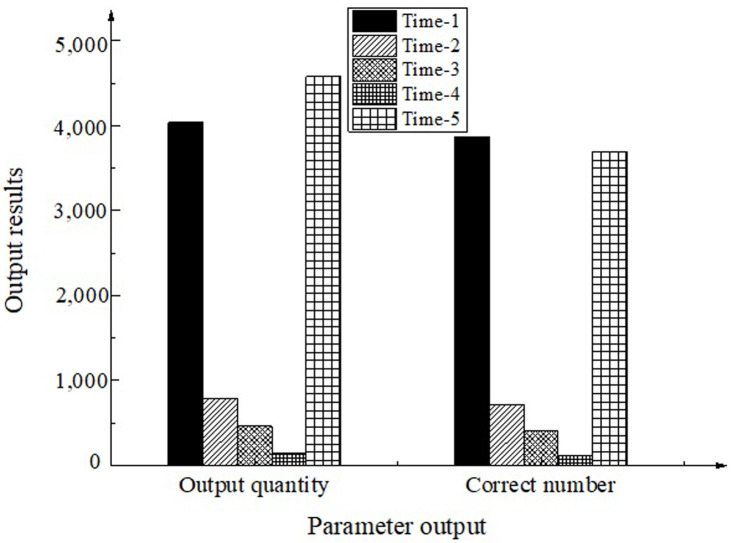
The output quantity of actions and their corresponding distribution changes of correct number under different action execution times.